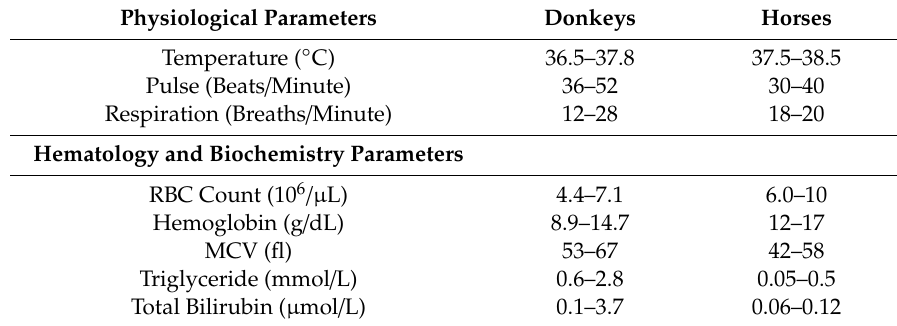
Table 1. Comparison of the physiological parameters between donkeys and horses. Source [11,12]. Physiological Parameters Donkeys